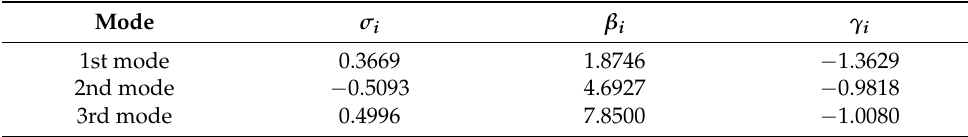
Table 1. Three coefficients of the modal function.